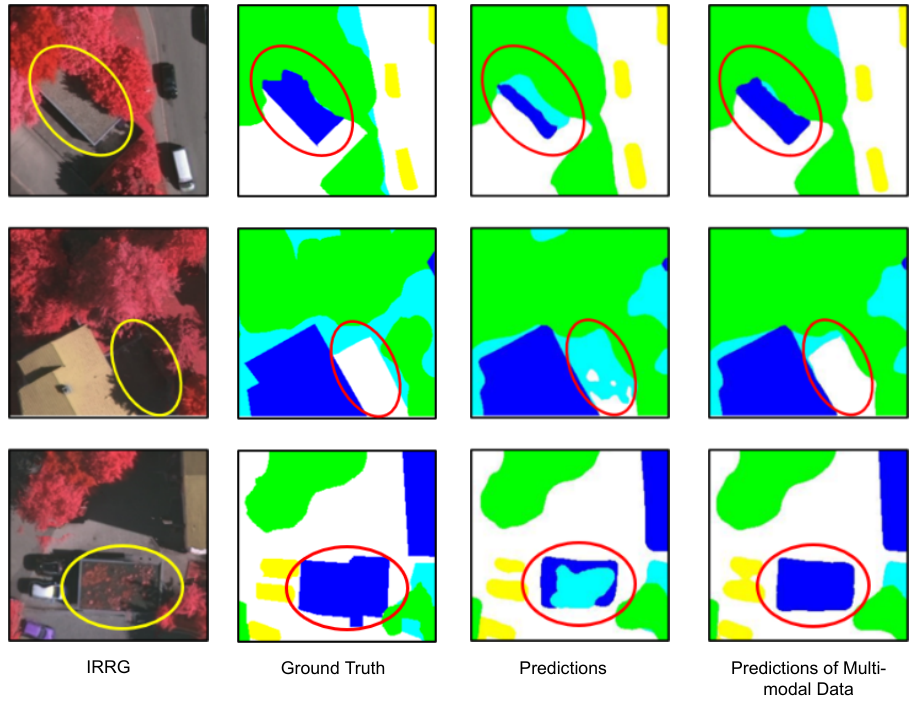
Figure 1. Predictions of objects with similar color and